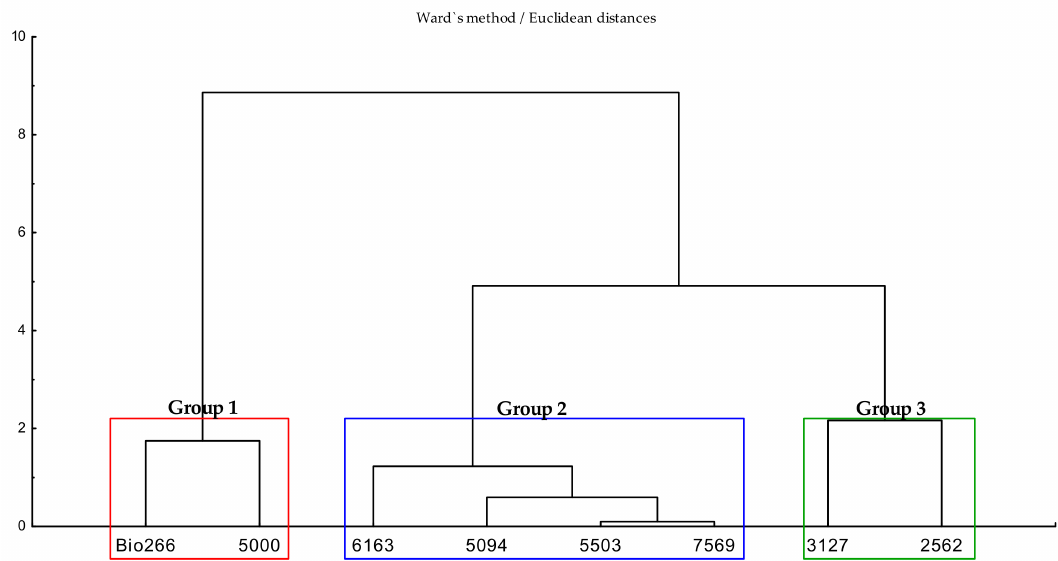
Figure 3. Dendrogram based on the Euclidean distance between eight sugarcane cultivars regarding the biological performance of wingless M. sacchari under no-choice conditions, analyzed seven days after release. Data submitted to multivariate ex-ploratory cluster analysis using Ward’s